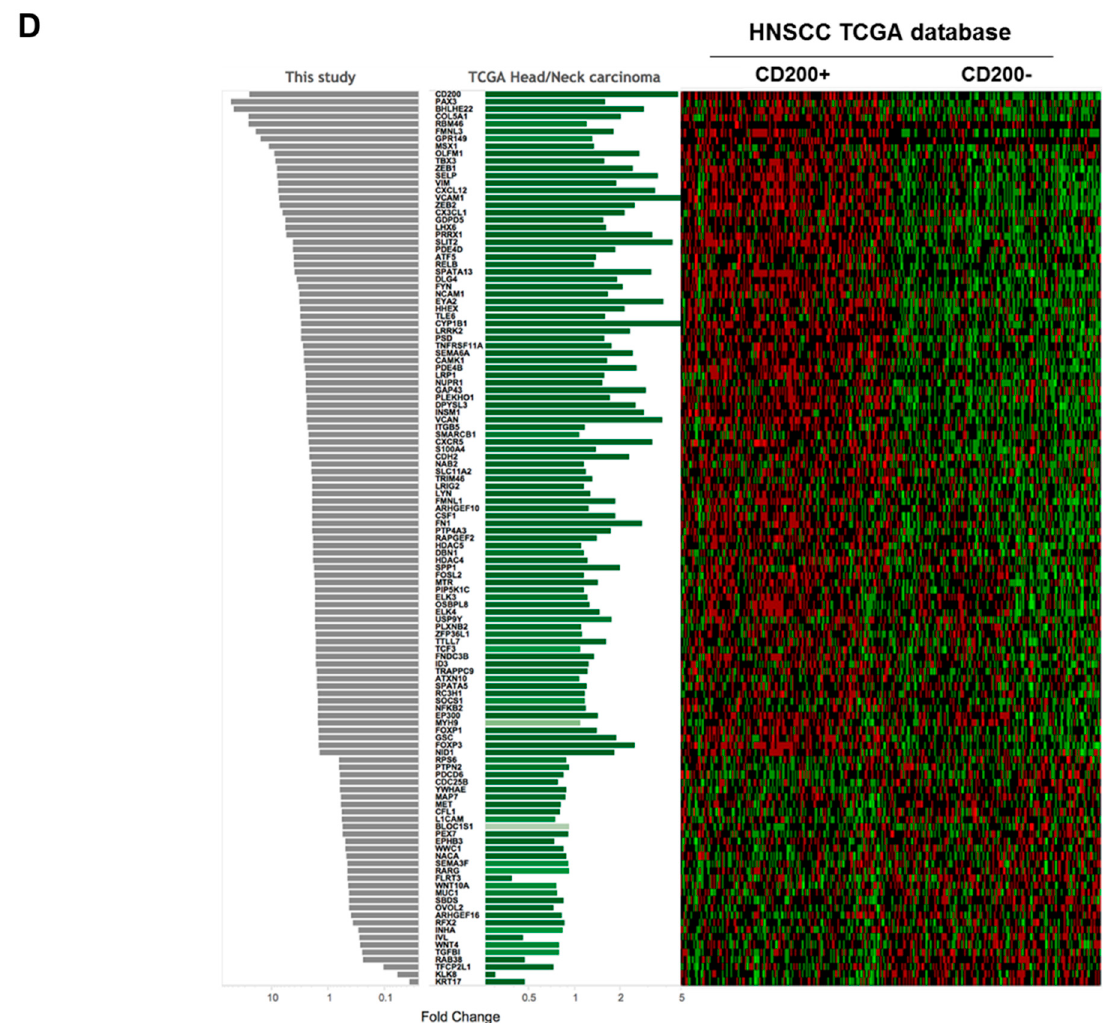
Figure 2. Mouse CD200 endowed MEER with better invasion ability by upregulating EMT-related genes, similarly to that observed in human CD200 + HNSCC patients. ( A ) MEER cells stably expressing CD200 were separated using flow cytometry into MEER / CD200 High and MEER / CD200 Low (left panel). MEER / control cells were established by transfecting cells with the empty vector pUNO1. Each cell type (1 × 10 4 cells) were placed in the upper chamber of a Matrigel-coated Transwell for 24 h. Cells that migrated to the underside of the filter through the Transwell were stained with crystal violet and counted under a microscope (100 µ m scale bar, right panel). Each error bar in the graph represents the average of three independent experiments (mean ± SEM). ( B ) Total mRNA from each cell type was assayed for the expression of EMT-related genes and their expression was normalized to that of mouse GAPDH RNA (mean ± SEM; n = 3). ( C ) Protein lysates (30 µ g) were prepared from each cell type and were analyzed using Western blotting. ( D ) TCGA mRNA data showing CD200 overexpression in HNSCC ( n = 522) patients, which were compared using the fold change values of total mRNA for MEER / control and MEER / CD200 High cells (Fold change > 1.5 or < 0.5). Student’s t -test and fold change were used to compare expression di ff erences between the two groups. p value < 0.05 and fold change > 2 (or < 0.5) were considered statistically significant.